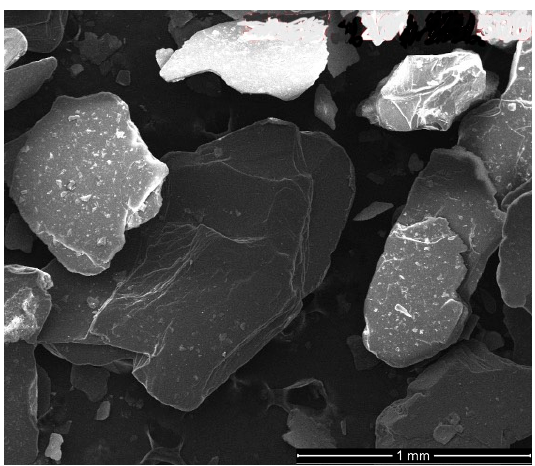
Figure 4. SEM images of the pristine material (Na-mica).